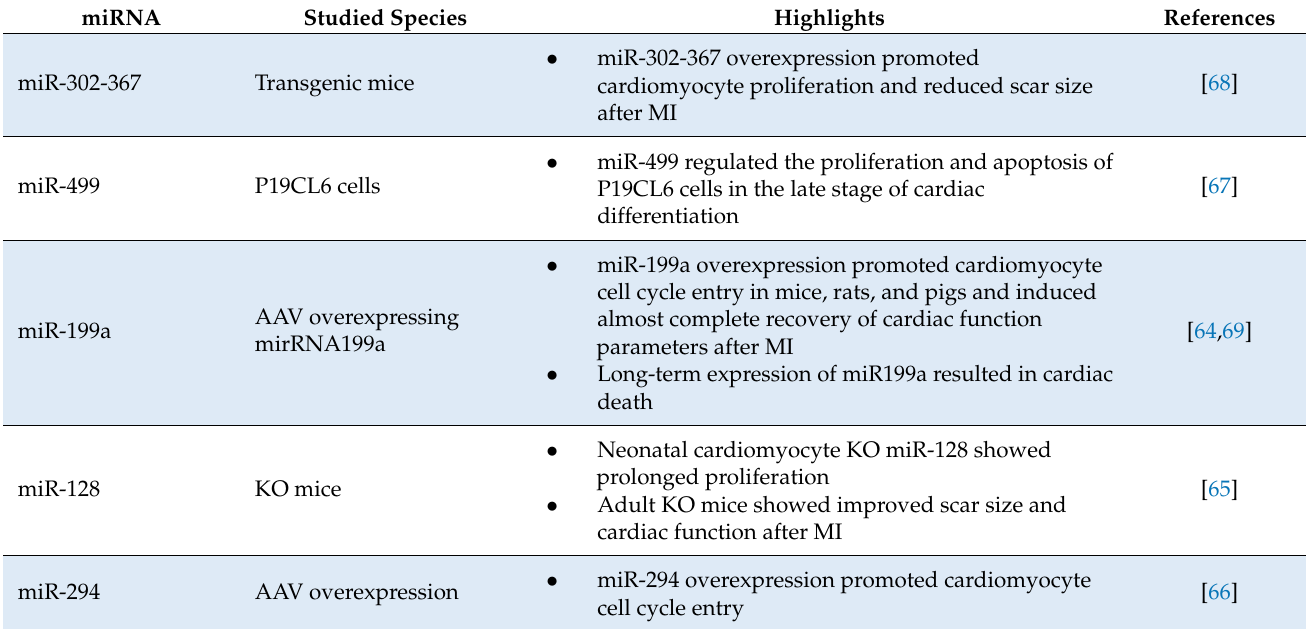
Table 3. microRNAs that are involved in cardiomyocyte cell cycle